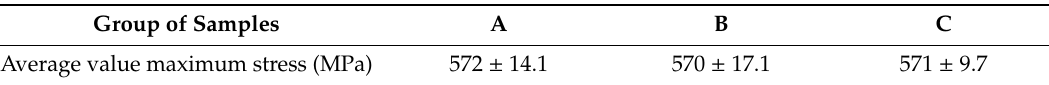
Table 4. Average values of maximum stress, including standard deviation, for the samples of all three groups.